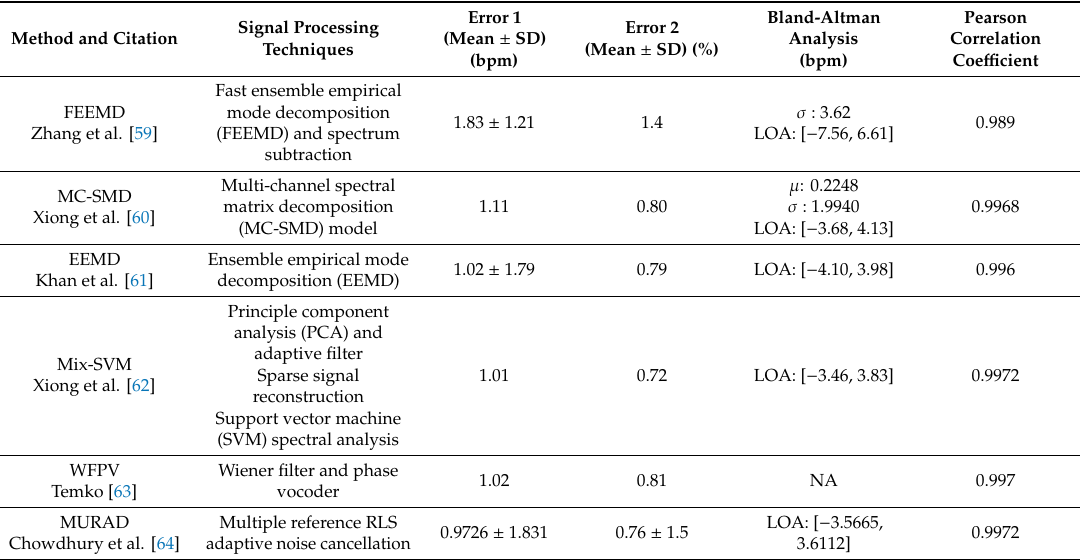
Table 5. Summary of wrist-type PPG techniques for HR monitoring, part